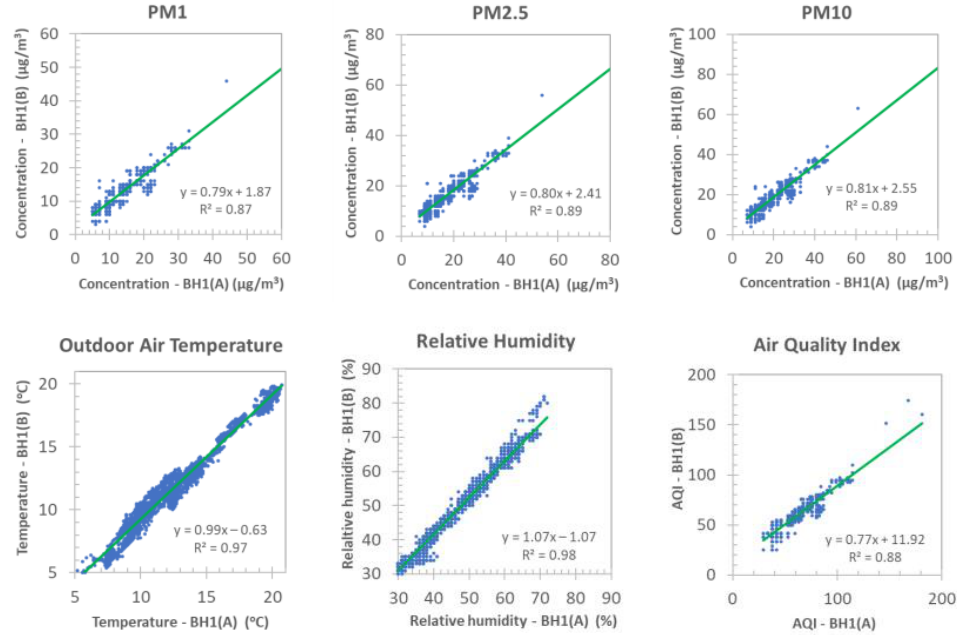
Figure 4. Correlation between the data series of BH1 sensors (A and B) for outdoor air monitoring at the urban site, between 15 and 18 April 2022 (sampling rate: 1–5 min, n = 3920).